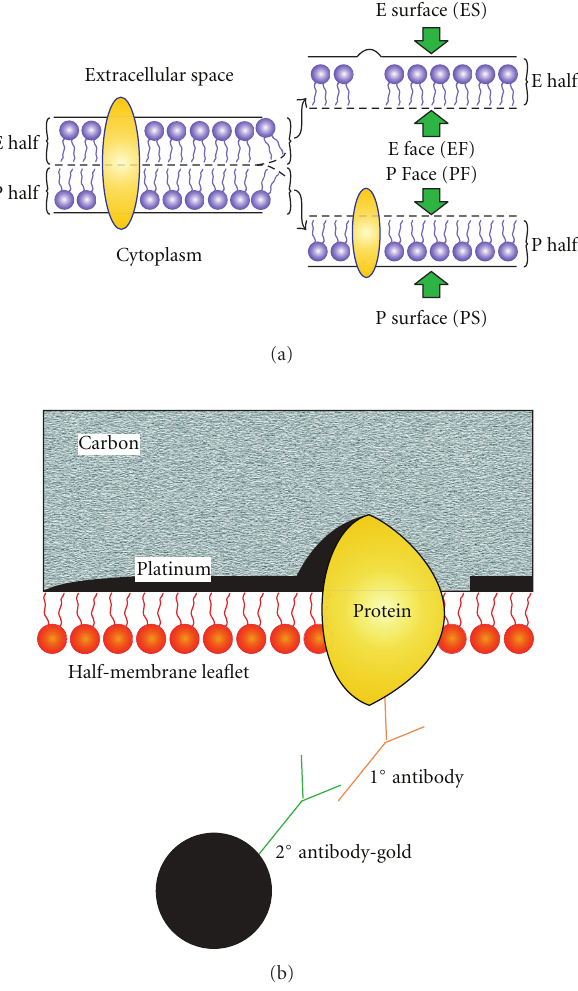
Figure 1: Nomenclature for describing the aspects of membranes revealed by freeze-fracture. (a) Cell samples are rapidly frozen and fractured. The freeze-fracture process splits the membrane exposing the fracture faces. The membrane comprises a lipid bilayer with intercalated proteins. The half-membrane leaflet adjacent to the extracellular space is termed the E half; that adjacent to the protoplasm is termed the P half. The term “fracture face” is reserved for the interior views of membranes exposed by freeze fracturing, while the term “surface” is used for the true, natural surfaces of the membrane. The fracture face of the P half is thus termed the P face (or PF), while that of the E half is termed the E face (or EF). The true surfaces of the membrane are correspondingly designated the P surface and the E surface (PS and ES), respectively. (b) Close-up view of the final product in FRIL as viewed in the transmission electron microscope. A platinum-carbon replica is made of the fractured specimen. The replica is treated with SDS to remove the cellular components apart from those attached directly to the replica. Proteins still attached to the replica are then immunogold-labeled. On examination in the electron microscope, the electron dense gold label is clearly visible against the replica, marking the target molecule in the plane of the membrane. The proteins embedded in the replica are detected using a primary antibody followed by a secondary antibody coupled to a colloidal gold